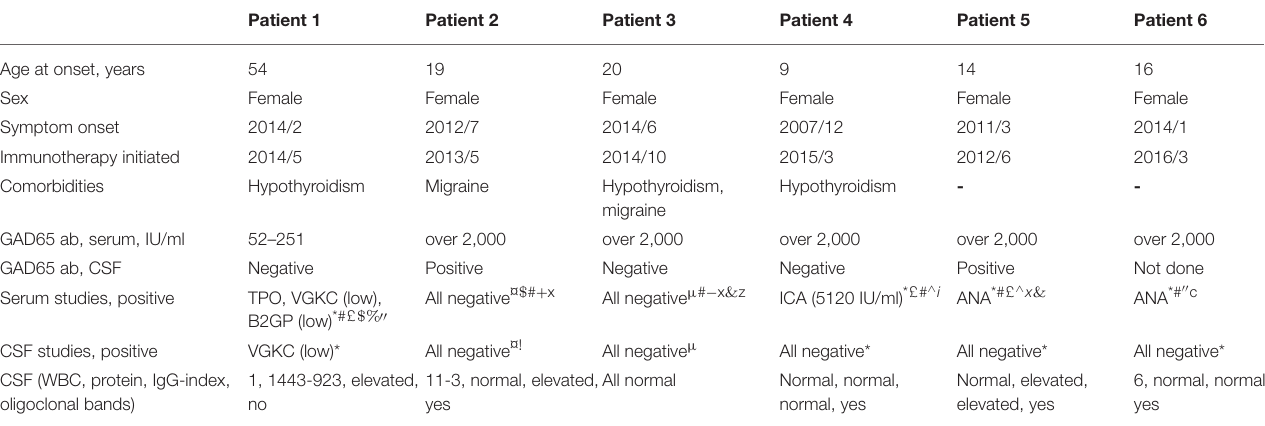
TABLE 1 | Individual patient characteristics, serological and cerebrospinal fluid